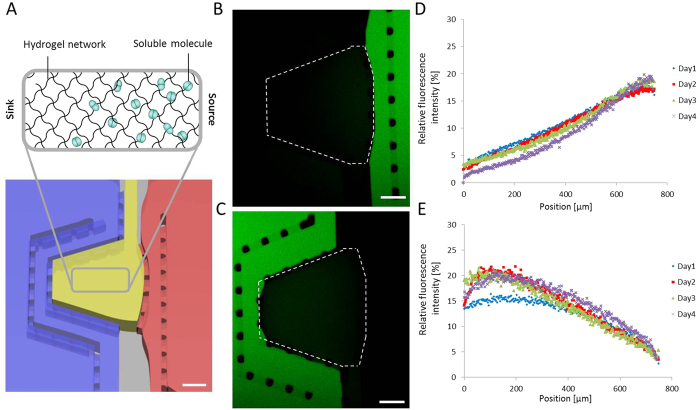
Generation of stable gradients of soluble molecules via source–sink diffusion.(A) Schematic representation of the diffusion of soluble molecules through the hydrogel compartment. Molecules diffused from the source reservoir (red) to the sink reservoir (blue) while forming a gradient of concentration. Fluorescently labeled LIF solution was loaded onto either side of the platform in the right (B) or left (C) reservoir and incubated for 4 days without renewal. Evolution of fluorescence intensity across the hydrogel compartment was monitored daily via confocal microscopy. Quantification of the fluorescence intensity displays gradual distribution of the molecule across the hydrogel compartment. (D) and (E) are the quantification of (B) and (C), respectively. Intensity was normalized relative to the intensity in the source and sink reservoirs and displayed as the mean value of three replicates. Scale bars indicate 200 μm.